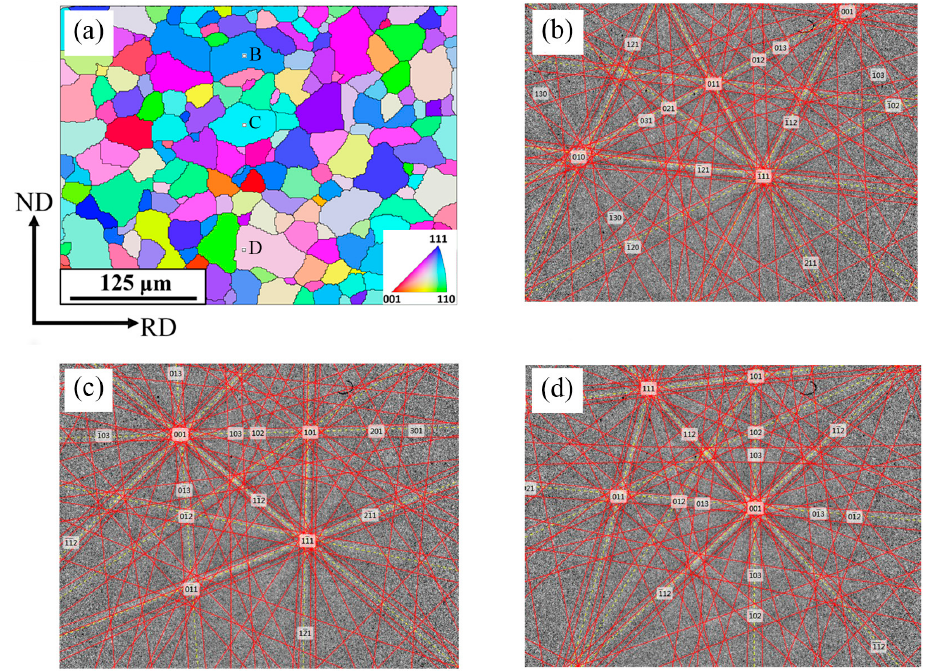
Figure 5. Electron back-scattered diffraction (EBSD) maps of Ni-49.1 at % Ti SMA: ( a ) microstructure; ( b ) kikuchi pattern of point B in ( a ); ( c ) kikuchi pattern of point C in ( a ); ( d ) kikuchi pattern of point D in ( a ).